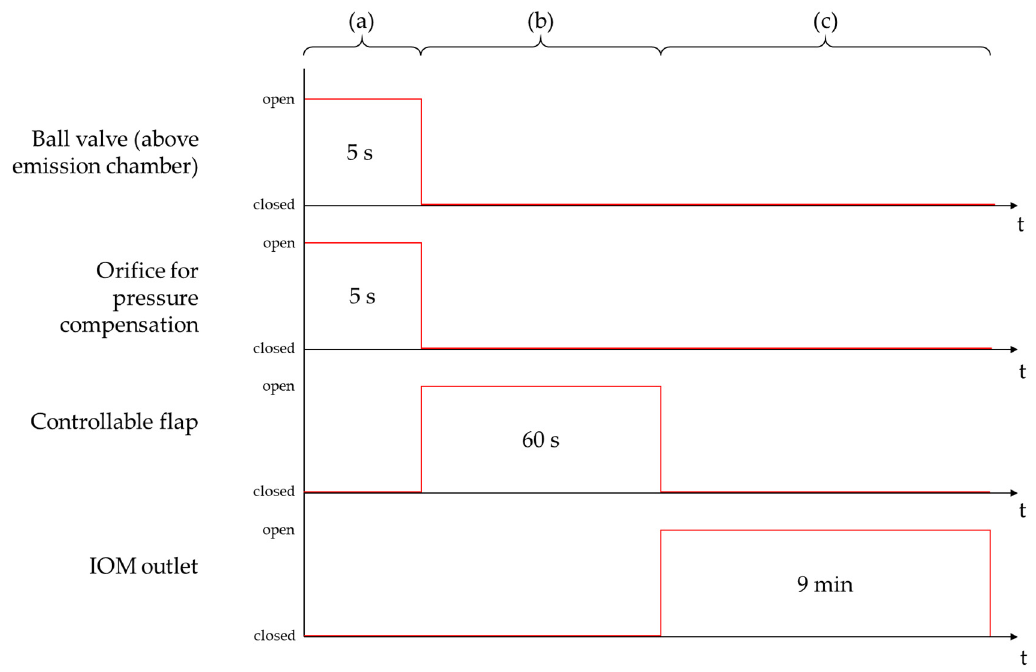
Figure 4. Schematic illustration of the three phases of the measurement course: atomization phase ( a ); transport phase ( b ); detection phase ( c ).